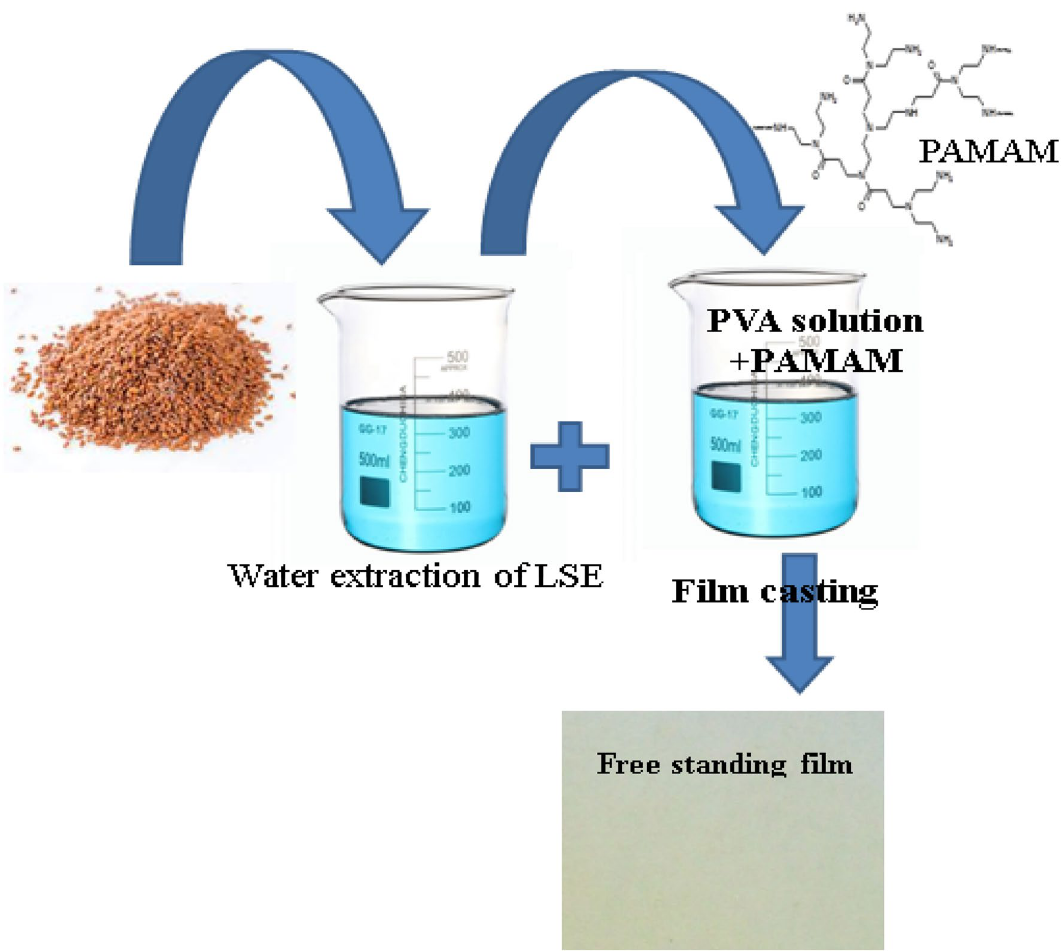
Scheme 1. Preparation steps for achieving free-standing films suitable for food packaging.